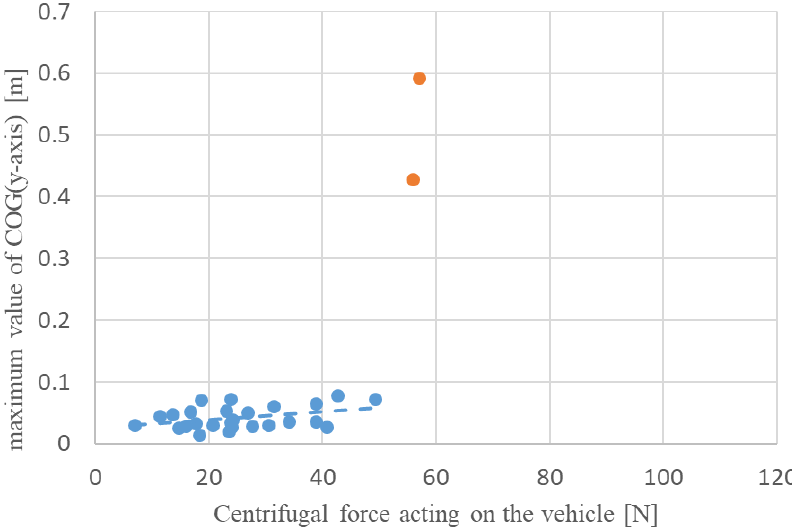
Figure 10. Relationship between the maximum value of COG ( y -axis) and centrifugal force on the vehicle during automatic turning.